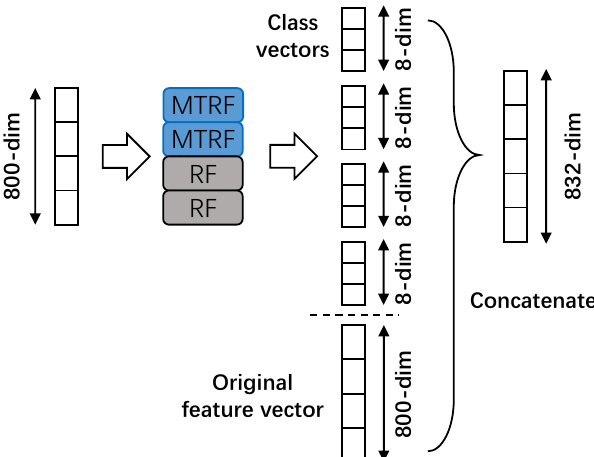
Figure 2. Details of how to concatenate feature vectors at the first level. In this figure, we suppose that there are eight action